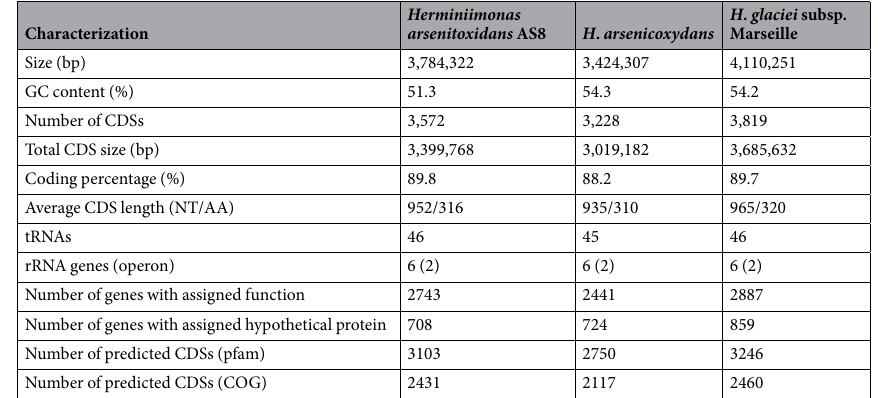
Table 3. General features of the H . arsenitoxidans AS8, H . arsenicoxydans , and H . glaciei subsp. Marseille genomes. All data are from this study with the exception of the genome size and GC content.